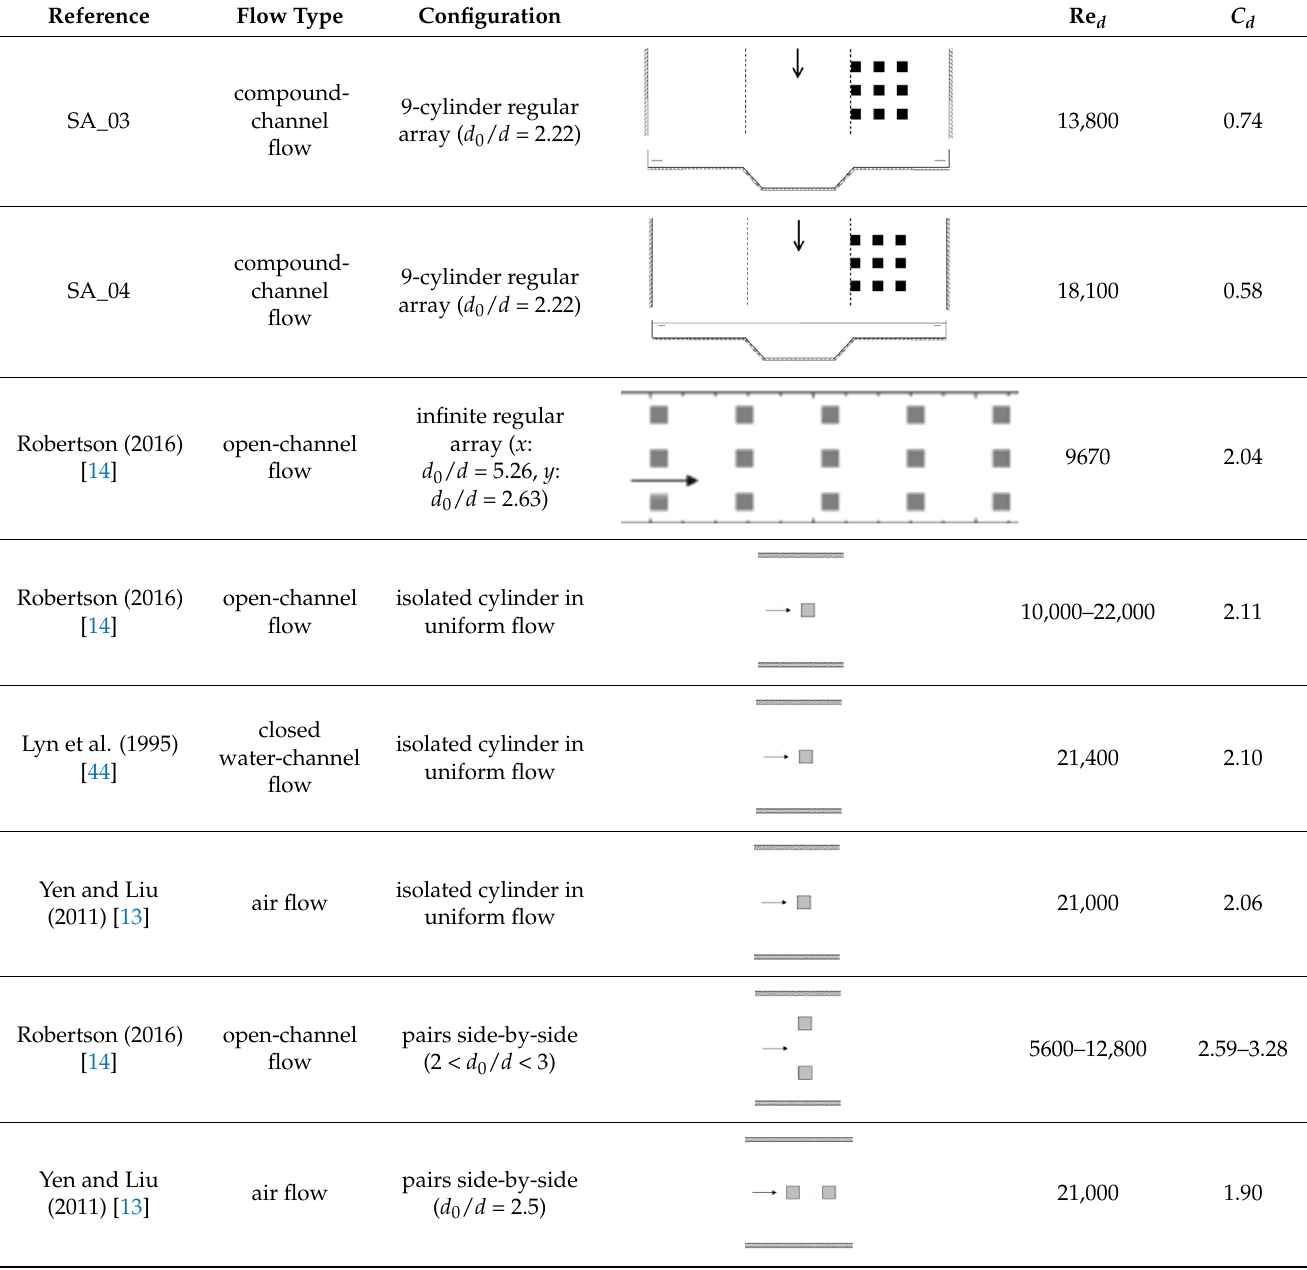
Table 2. Drag coefficients estimated for various configurations of square cylinders.